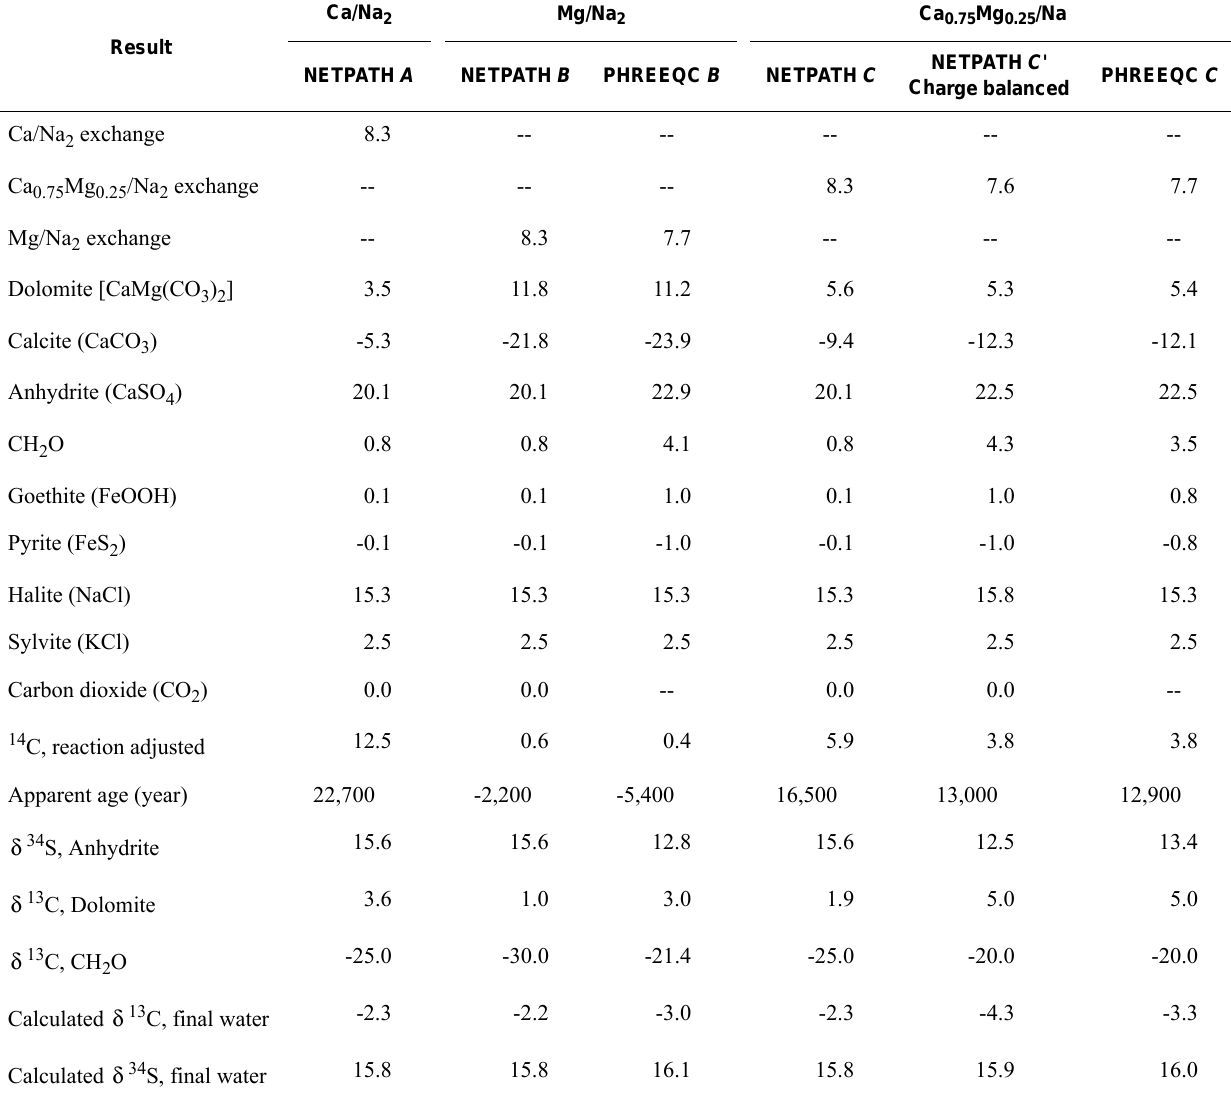
Table 54. Mole-balance results for example 18. [Results are in millimoles per kilogram water, unless otherwise noted. 14 C, carbon-14 in percent modern carbon δ (pmc); 13 C, carbon-13 in permil rPDB (Pee Dee Belemnite); 34 S, sulfur-34 in permil CDT (Canyon Diablo Troilite); CH 2 O represents organic matter; Positive numbers for mineral mass transfer indicate dissolution; negative numbers indicate precipitation; For exchange reactions, positive numbers indicate a decrease in calcium and (or) magnesium and an increase in sodium in solution. --, reactant not included in model]